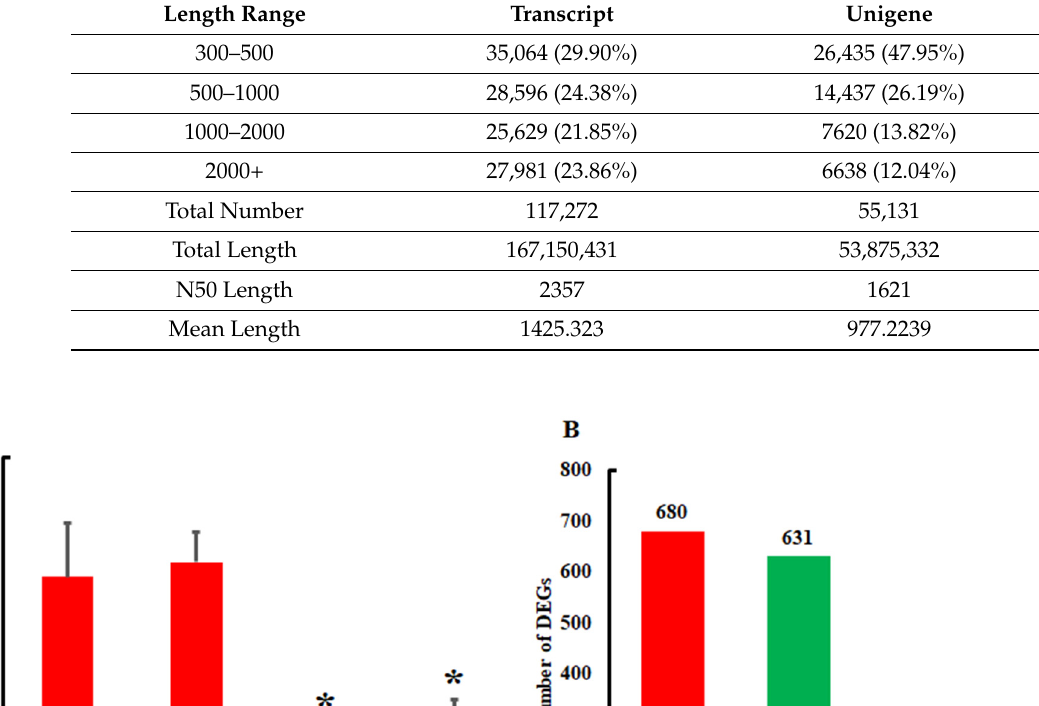
Table 2. Distribution of splicing length.